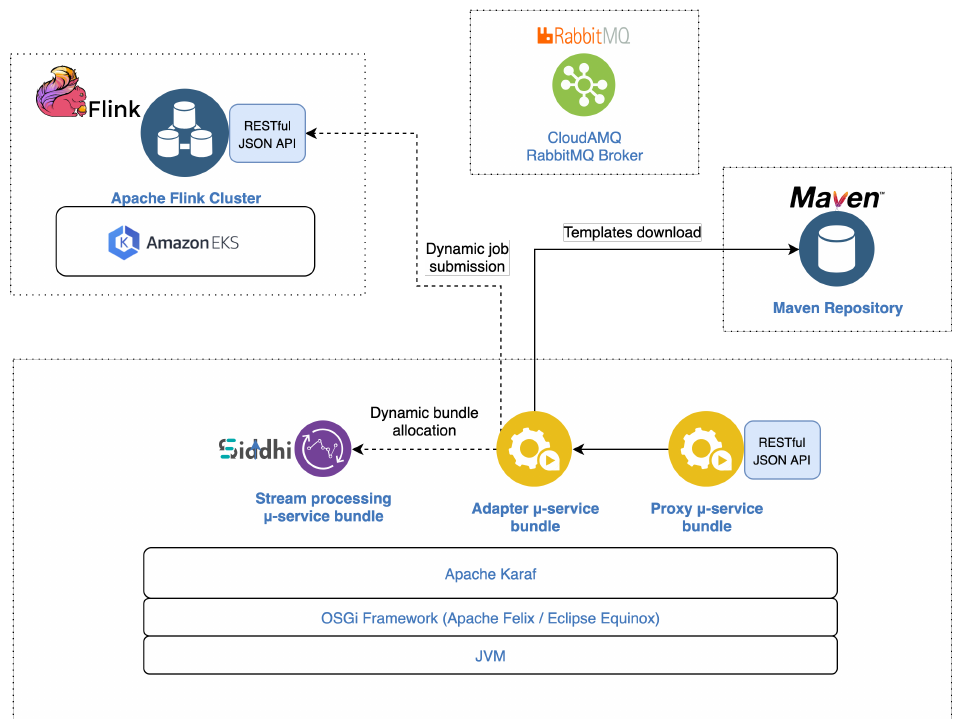
Figure 2. Prototype